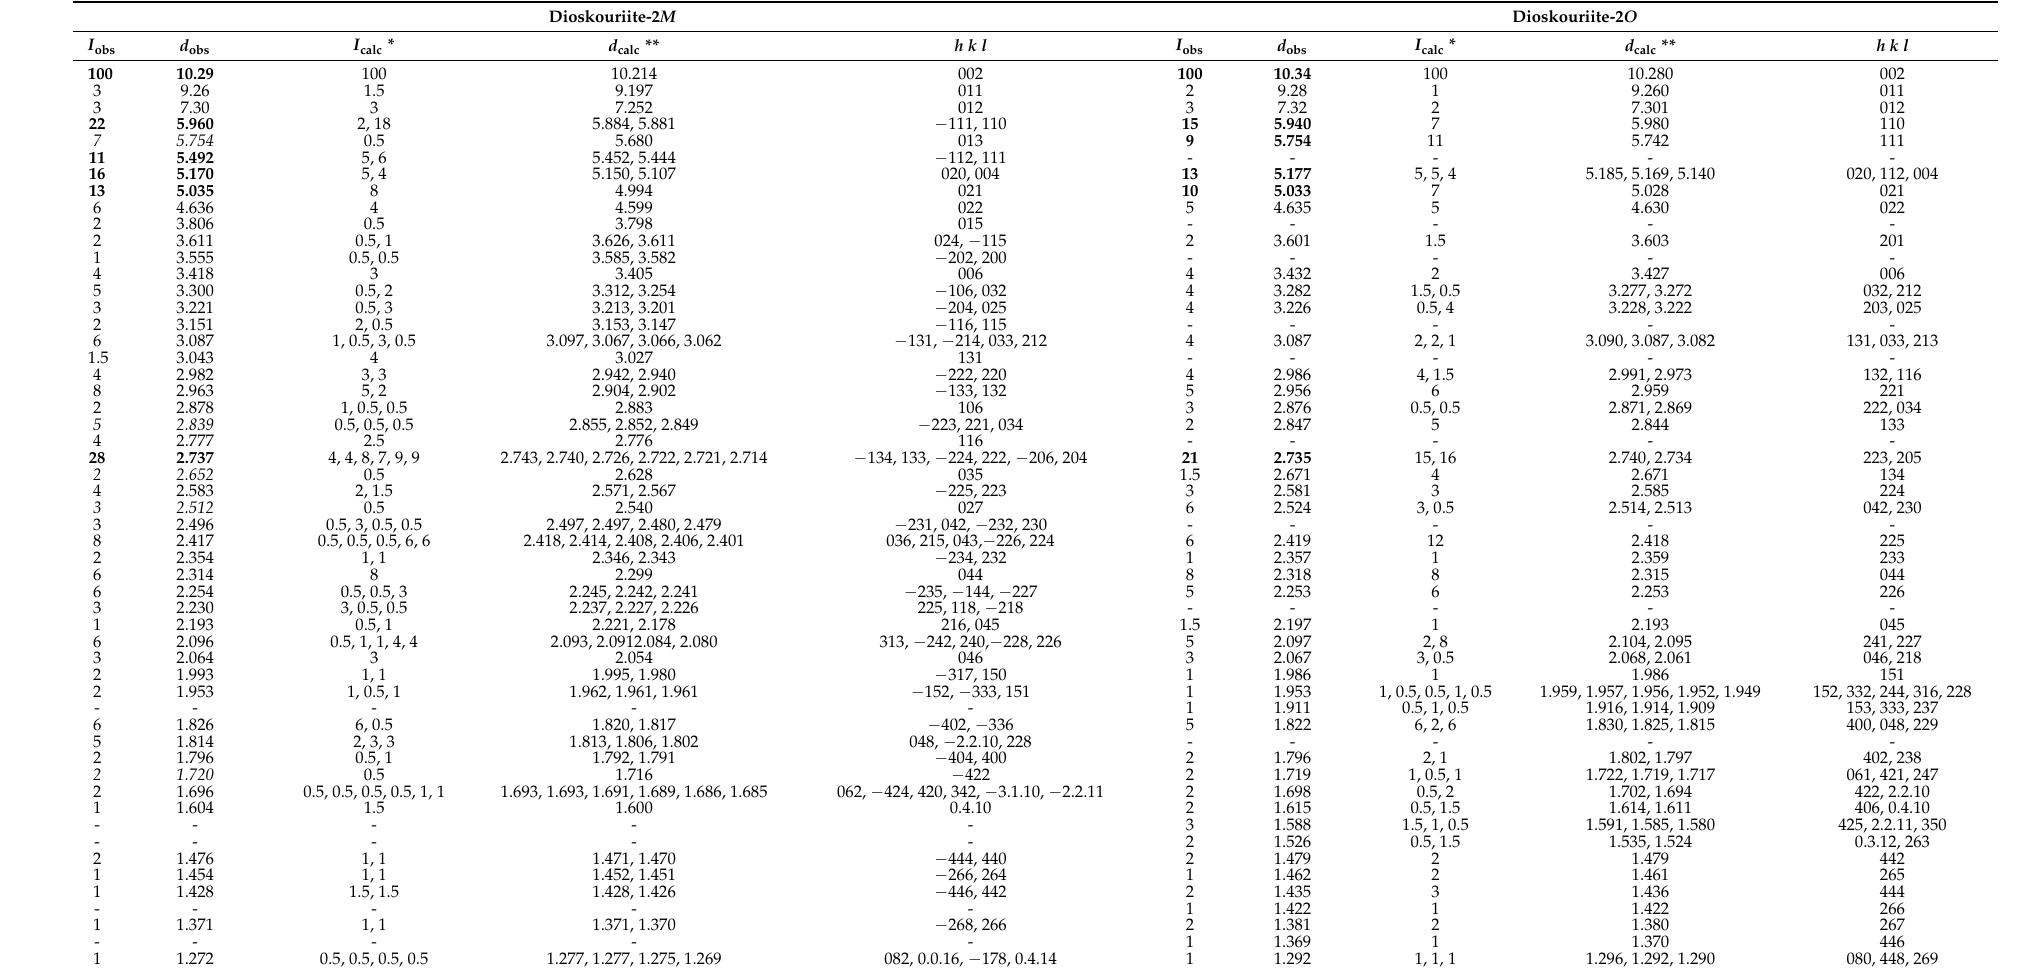
Table 2. Powder X-ray diffraction data ( d in Å) of the two polytypes of